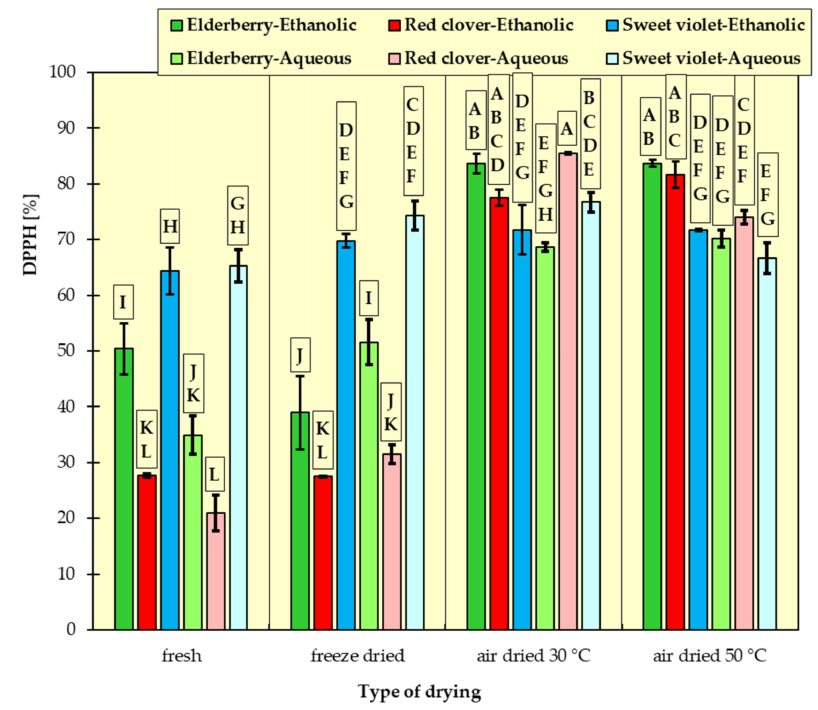
Figure 3. Amount of remaining 2,2-diphenyl-1-picrylhydrazyl (DPPH) as an antioxidant